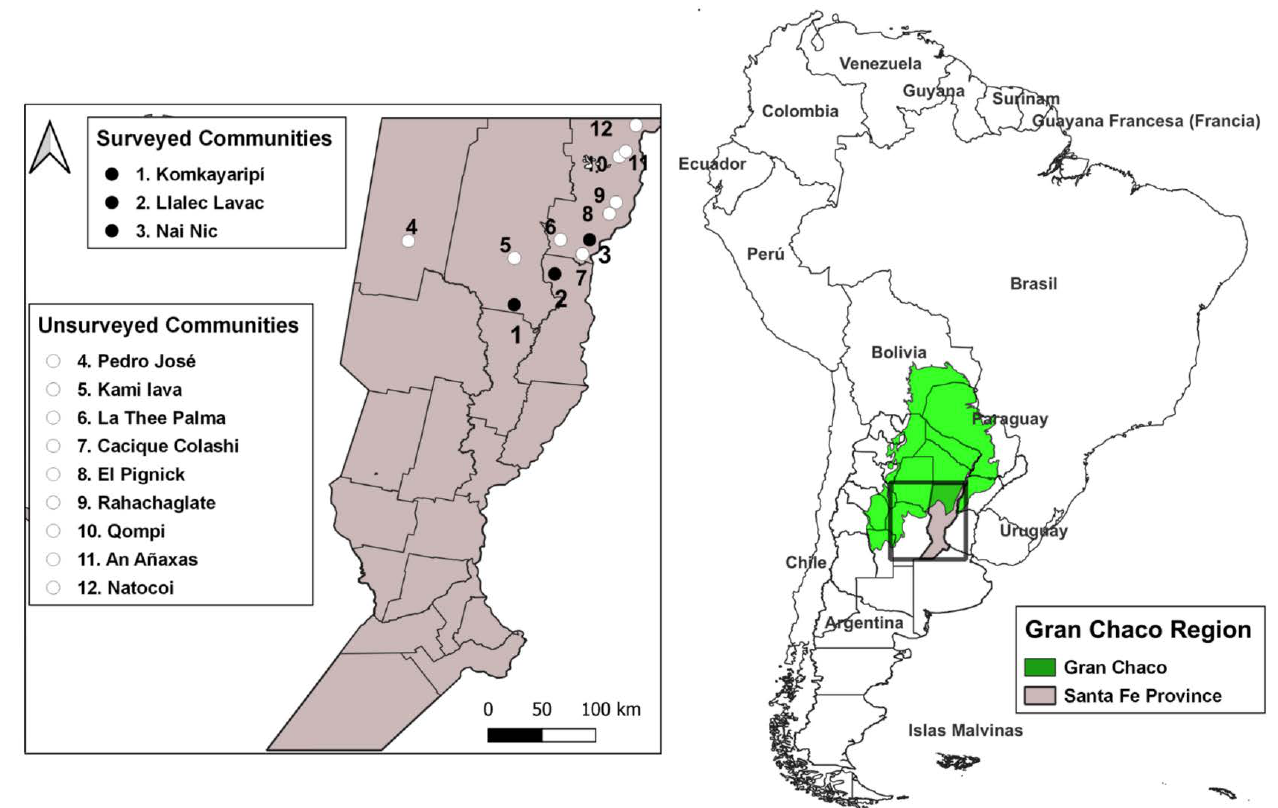
Figure 1. Map of geographic localization of the southern Chaco surveyed